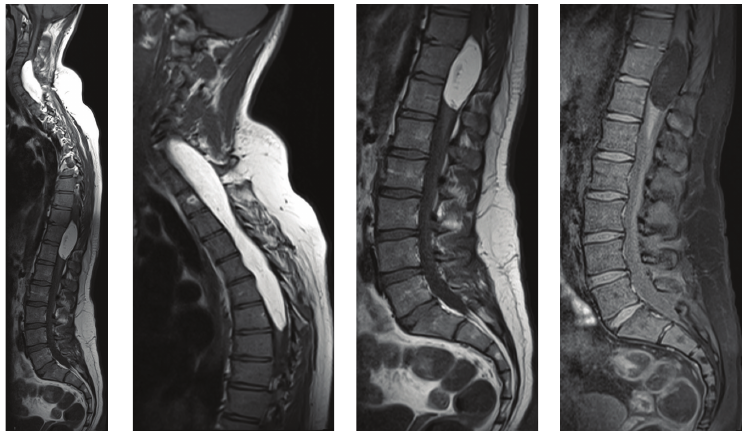
Figure 3: Sagittal T1 imaging of the spine with fat suppression (far right) demonstrating intradural spinal cord